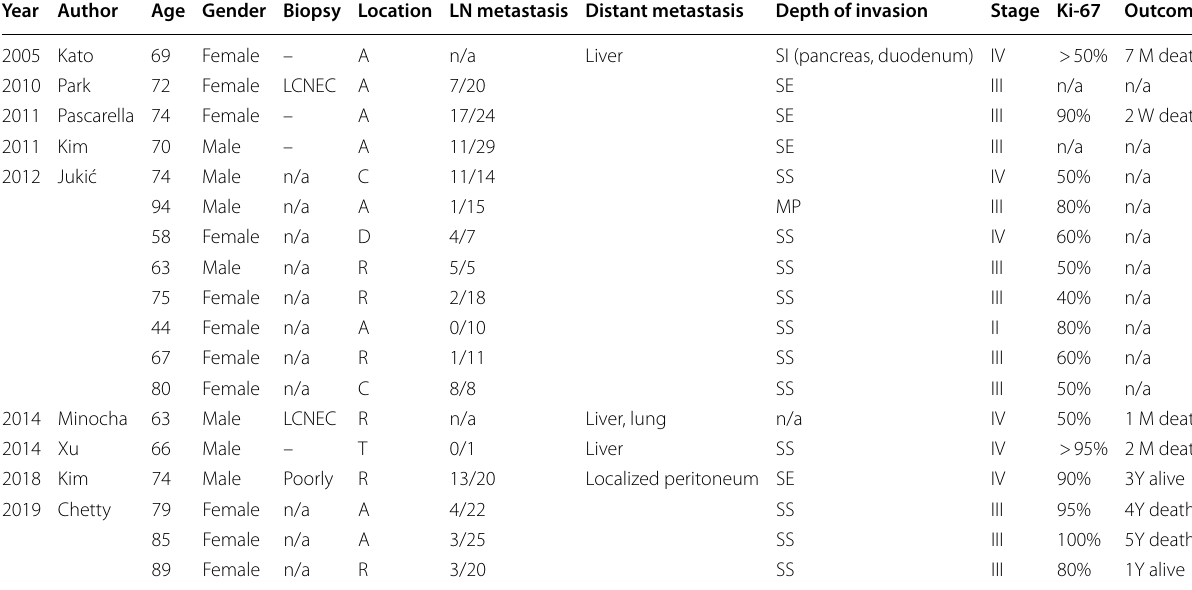
Table 1 Clinicopathologic findings of LCNEC of the colorectum that previously